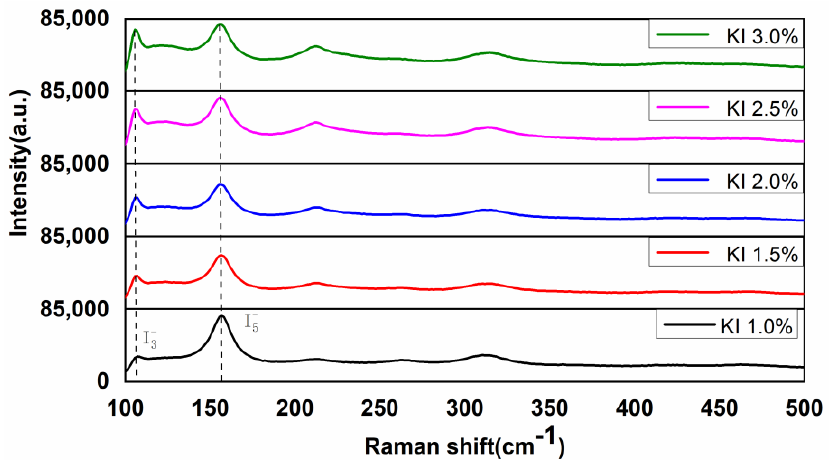
Figure 4. Raman spectrum of PVA polarizing films which were stretched 6 times, prepared in the correcting tank with the concentration of KI from left to right being set to 1.0%, 1.5%, 2.0%, 2.5% and 3.0% respectively.